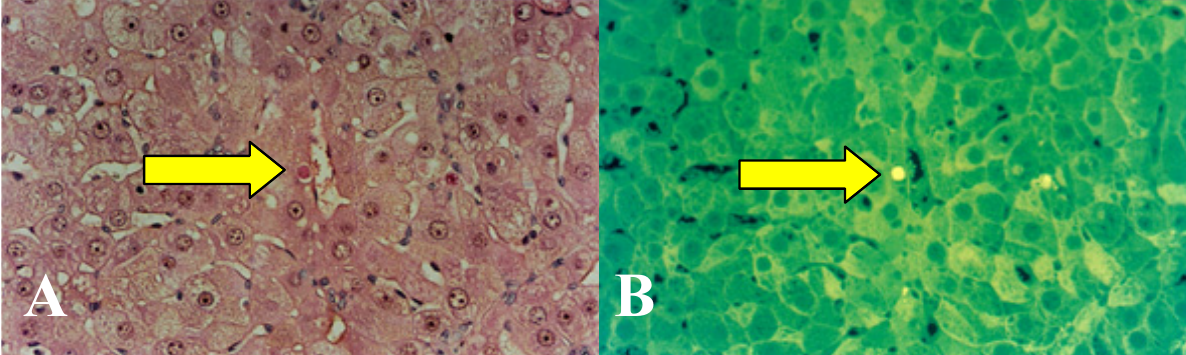
FIGURE 3 - Hepatic apoptotic body visualized by transmitted light microscopy (A) and fluorescent microcopy (B). 40X objective